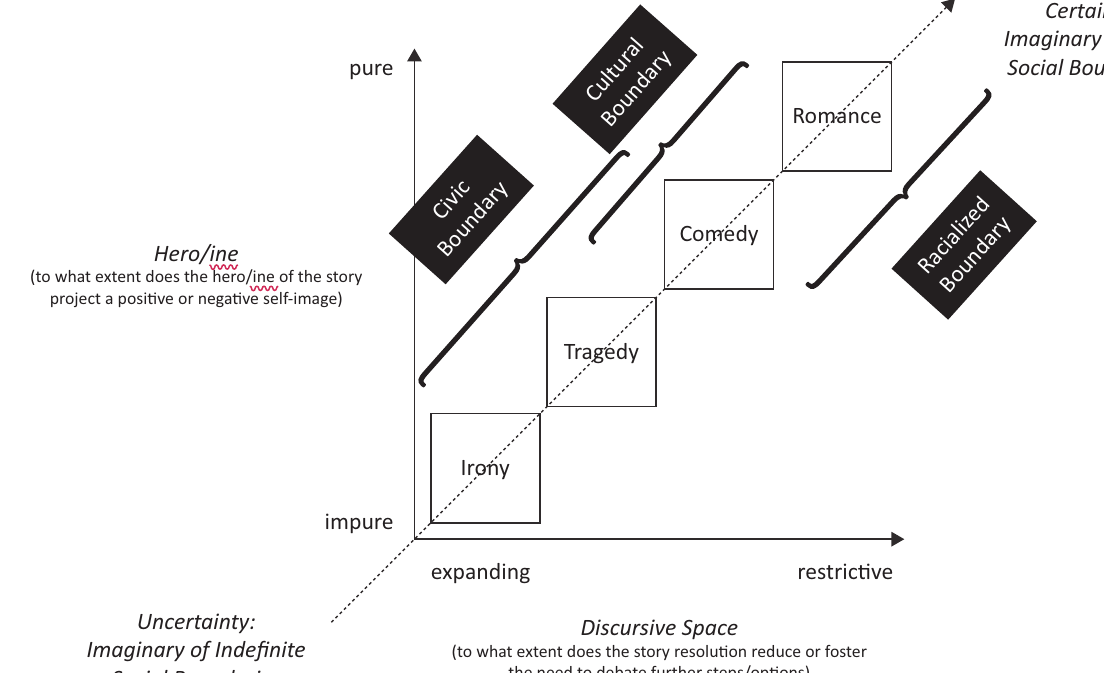
Figure 3. Schematic representation of the link between narrative genres and social boundary types (own